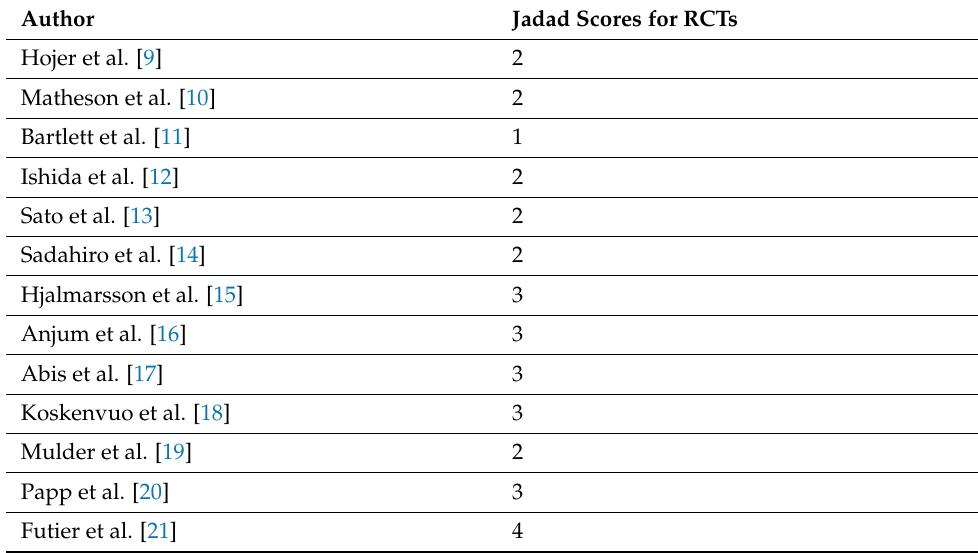
Table 2. Methodological quality assessment according to Jadad